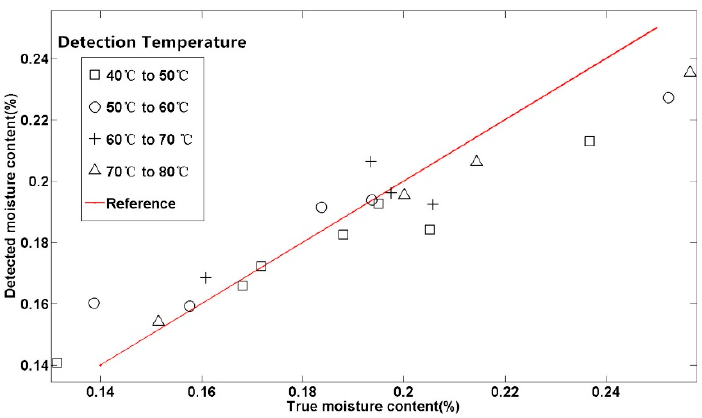
Figure 8. Detection result of designed paddy moisture sensor.